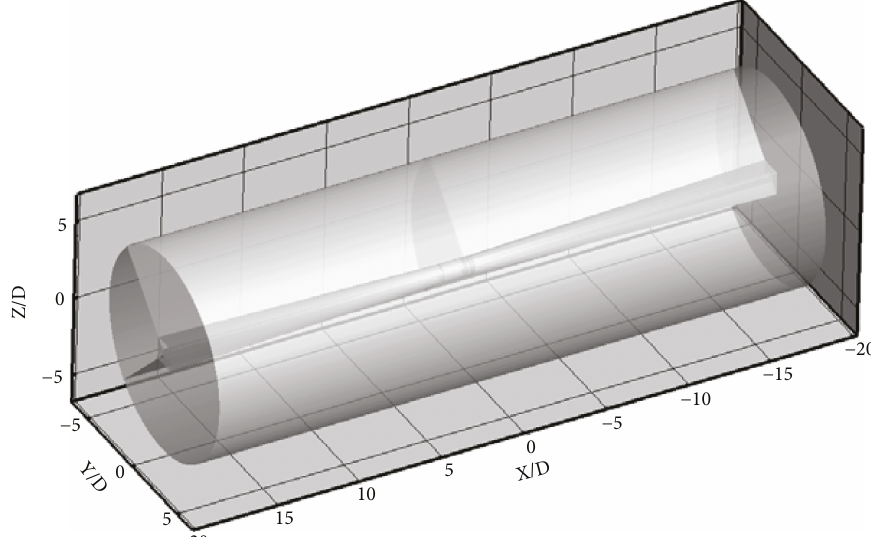
Figure 4: Computational domain encompassing the SRP con fi guration.